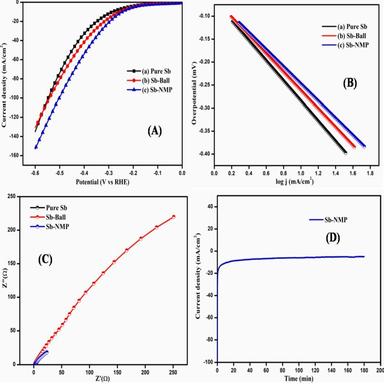
(A) LSV spectra, (B) Tafel slope (C) EIS spectra of pure-Sb, Sb-Ball mill, Sb-NMP; (D) CA test of Sb-NMP for 3 h.